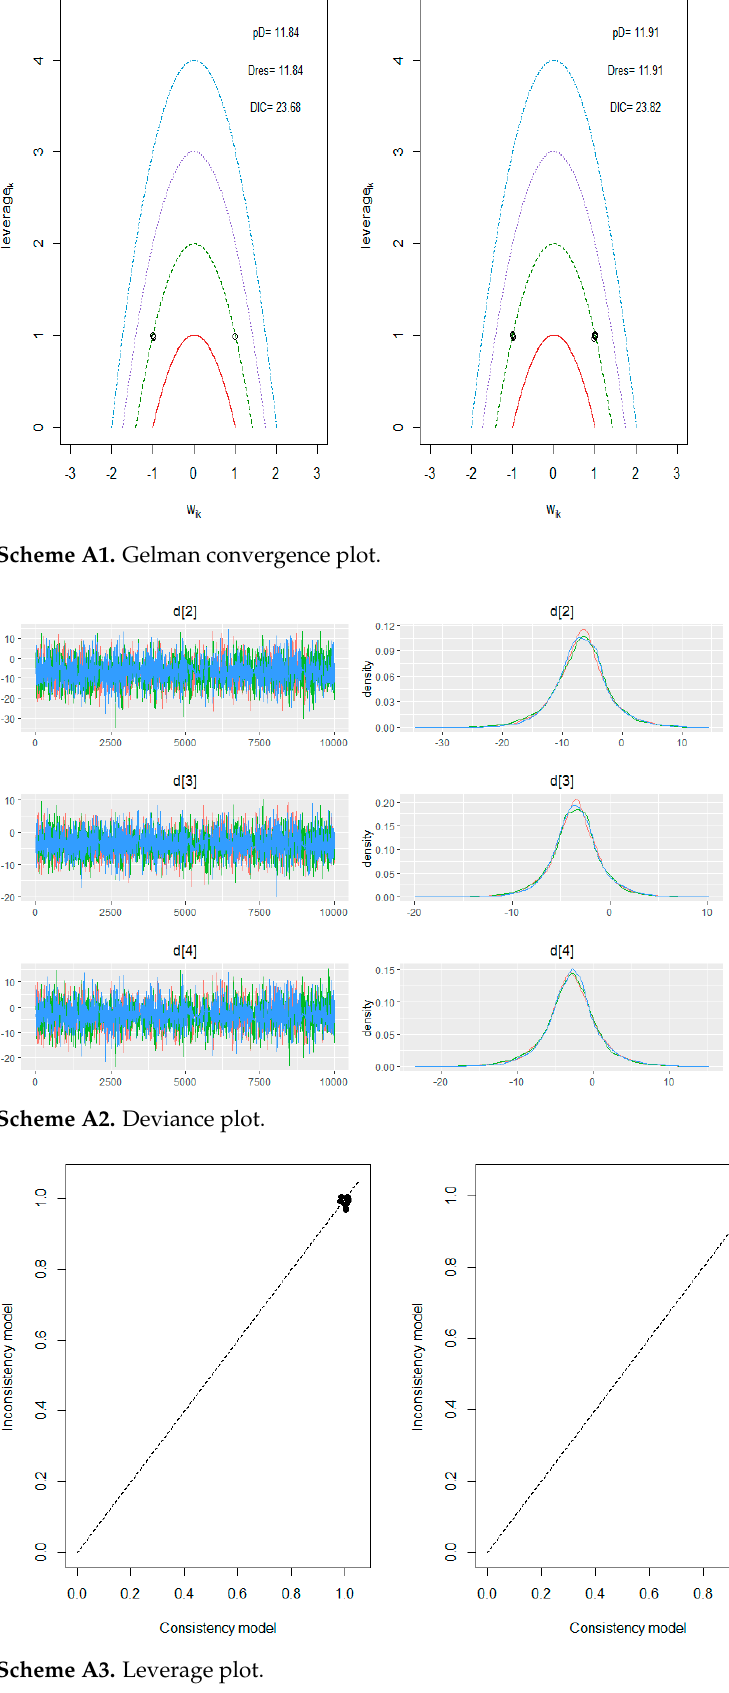
Scheme A3. Leverage